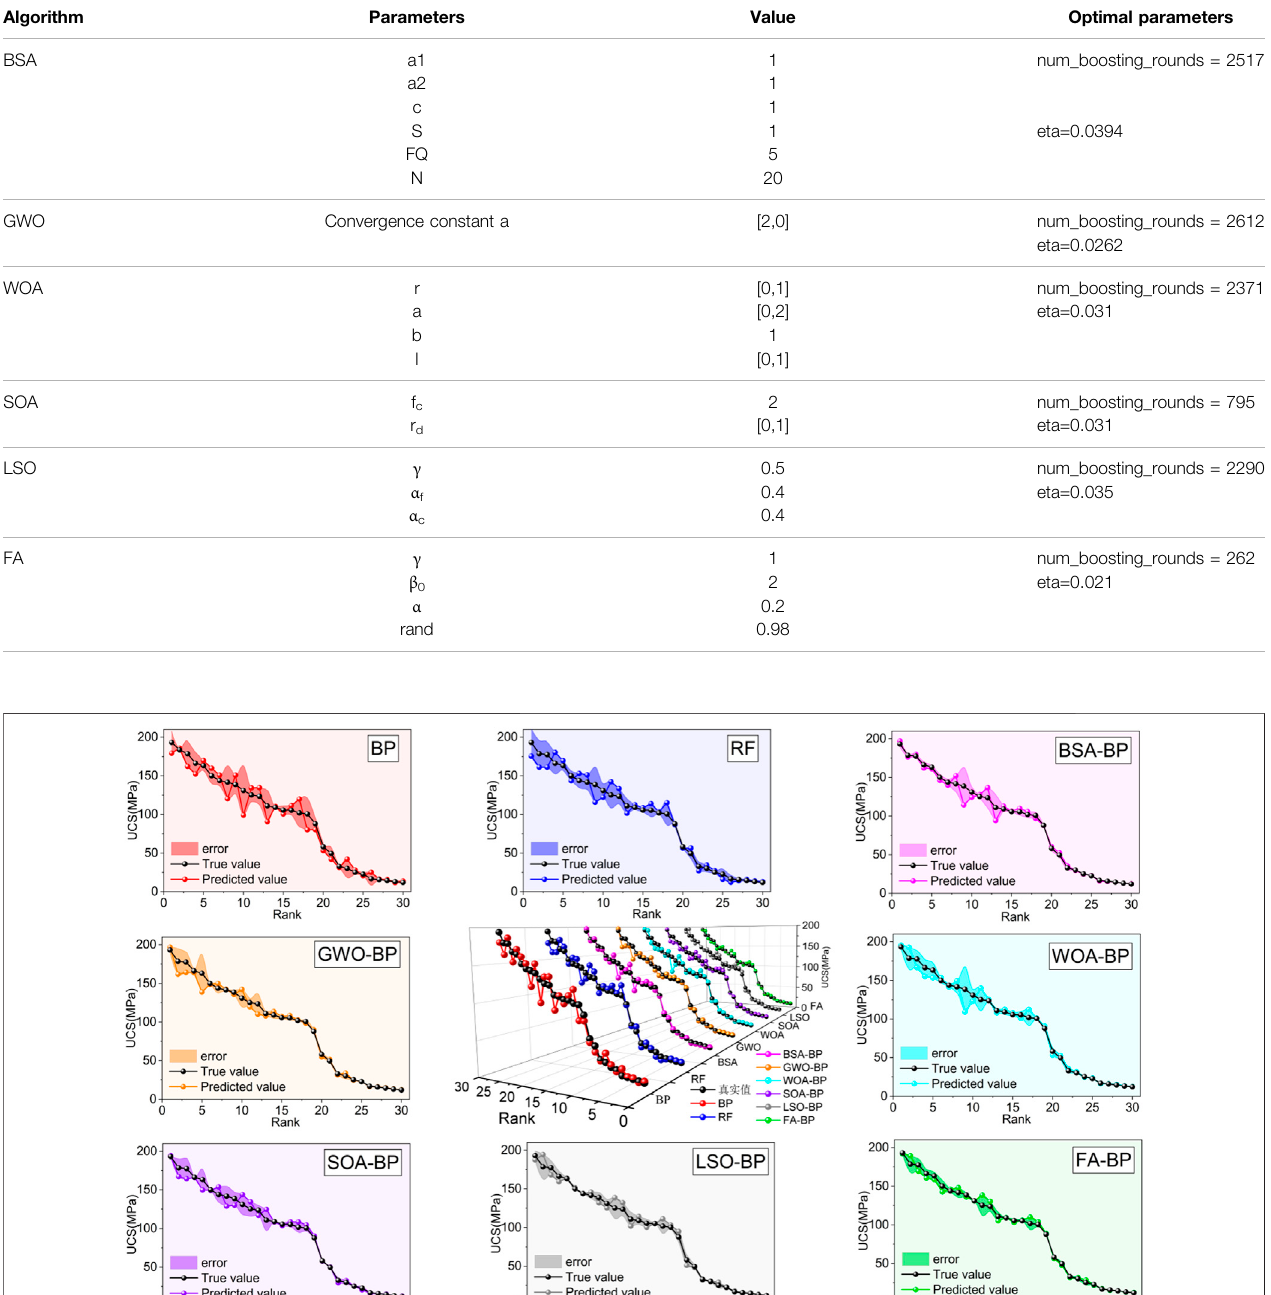
TABLE 2 | Initial parameters for hybrid model optimization.